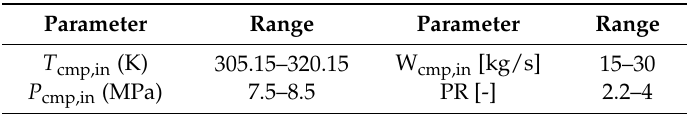
Table 3. Investigated bottoming cycle